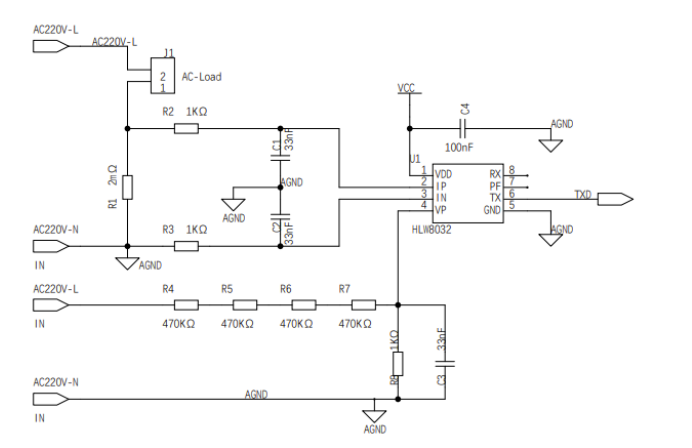
Figure 6. The power consumption calculation and acquisition circuit.